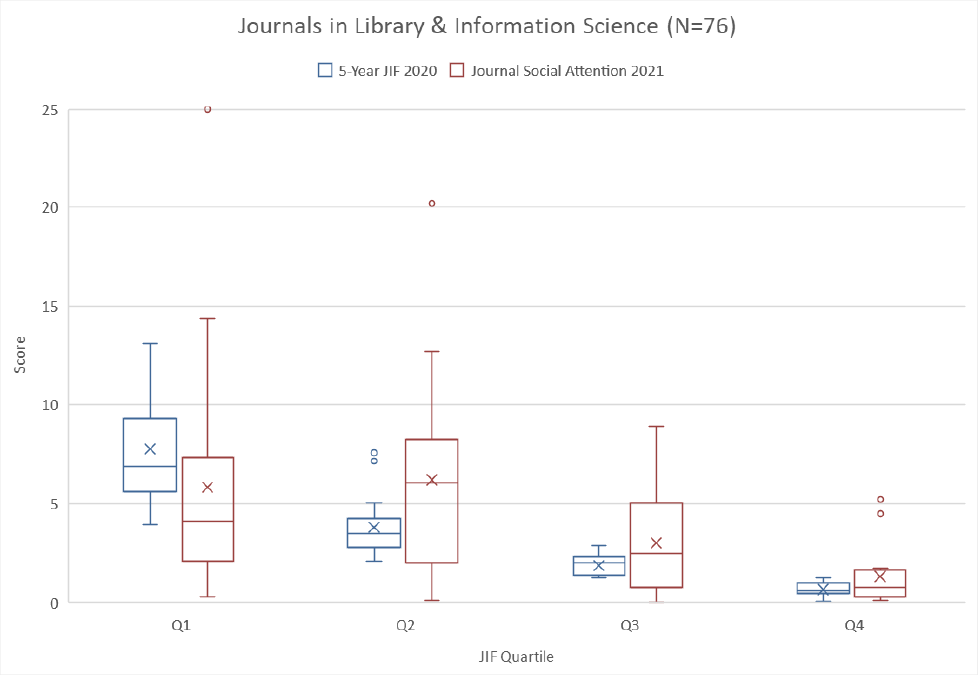
Figure 1. The 5-year Journal Impact Factor (2020 edition) and the Journal Social Attention (2021 edition) by JIF quartiles. The mean is represented by a cross. The differences between the groups are all significant ( p < 0.01), except between Q1 and Q2 for Social Attention.